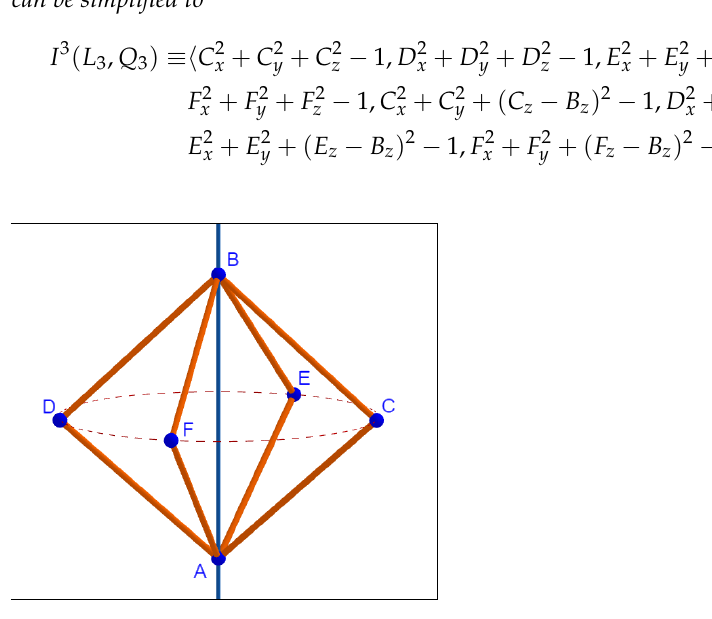
Figure 6. A linkage whose dimension grows in degenerate